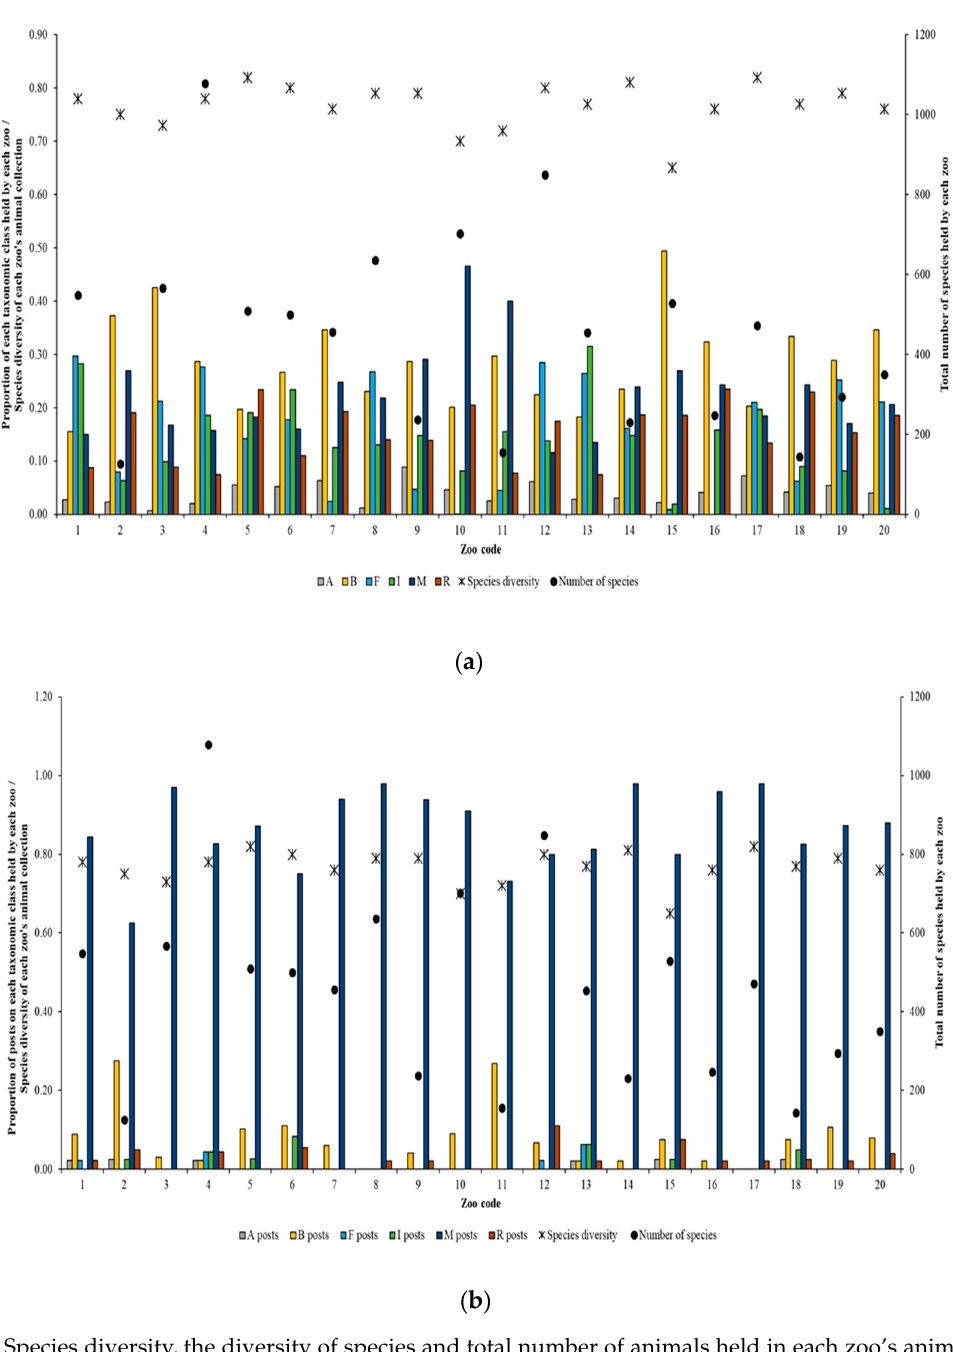
Figure 4. ( a ) Species diversity, the diversity of species and total number of animals held in each zoo’s animal collection compared to the proportion of each taxonomic class held (top graph). A = Amphibian, B = Bird, F = Fish, I = Invertebrate, M = Mammal, R = Reptile. ( b ) The proportion of all YouTube videos posted about for a specific taxonomic class. Number of species given as black dots and species diversity given as black crosses. A = Amphibian, B = Bird, F = Fish, I = Invertebrate, M = Mammal, R = Reptile.